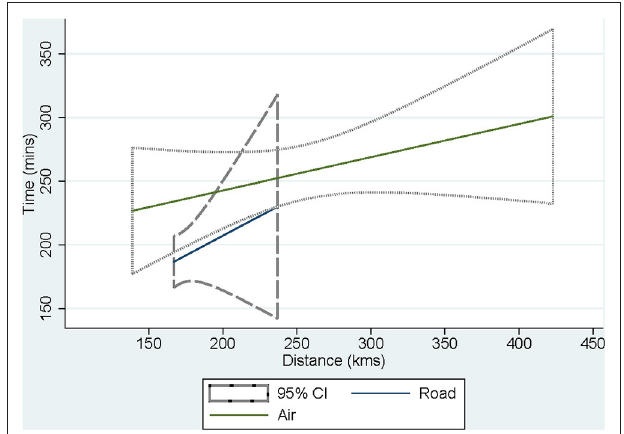
FIGURE 1 | Comparison through univariate regression analysis of decision to arrival time at John Hunter Hospital for air and road transfers by distance. Extrapolating from these separate regressions suggested that the distance at which the extra speed of an aircraft made up for the delays involved in booking an aircraft was 299km.